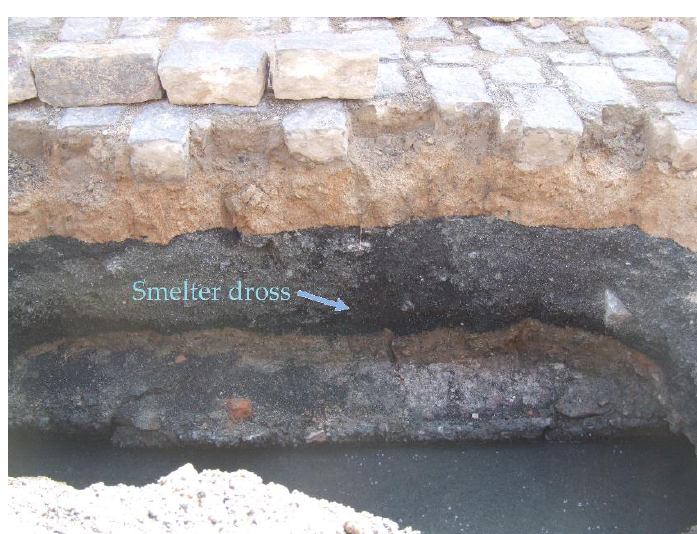
Figure 2. The smelter dross layer under the street pavement, 2008.